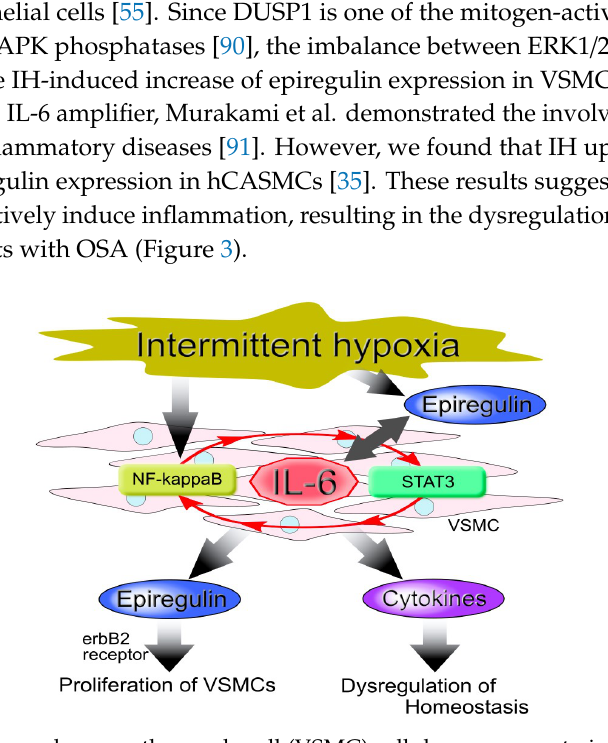
Figure 3. Model of vascular smooth muscle cell (VSMC) cellular responses to intermittent hypoxia (IH). IH induces the up-regulation of interleukin (IL)-6 via activation of the nuclear factor (NF)-κB